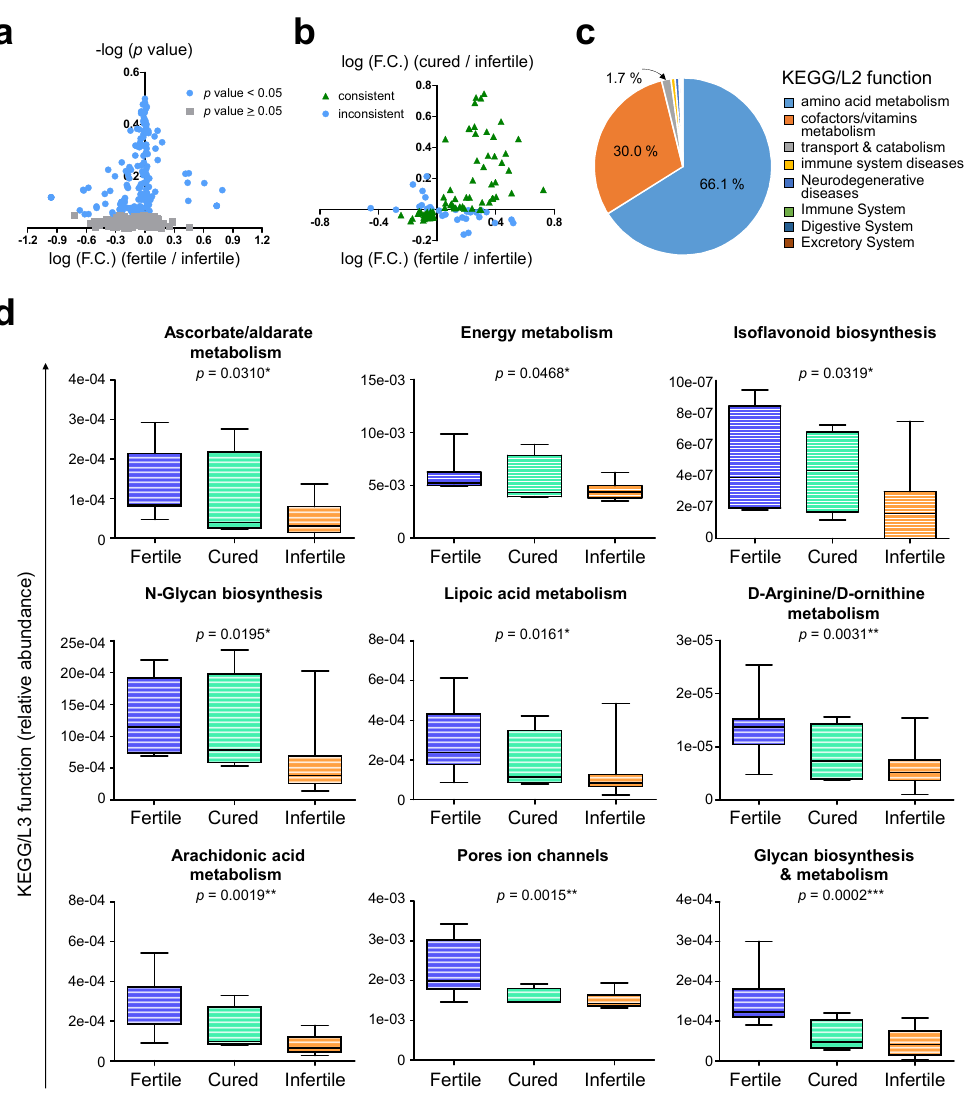
Figure 8. Functional impacts on KEGG pathways governed by altered cervical microbiomes in endometriosis patients with different reproductive ability. ( a ) As compared to fertile patients, the significant altered KEGG/L3 functions (in blue) in infertile patients were plotted by t-test. ( b ) Among the significantly altered KEGG/L3 functions in ( a ), the dot plot indicates the key functions (in green) that can be re-gained or re-suppressed in cured patients by anti-infertility treatments. ( c ) The pie chart indicates the proportions of 8 major KEGG/L2 functions which the key altered functions in ( b ) can be categorized into. The data in ( a ) to ( c ) were generated by using average scores of functional annotations among patient groups. ( d ) Among the key altered functions in ( b ), the box plots indicate nine KEGG/L3 functions which show significant linear trend among patient groups with different reproductive ability by one-way ANOVA. Statistical significance: *, p < 0.05; **, p < 0.01; ***, p <